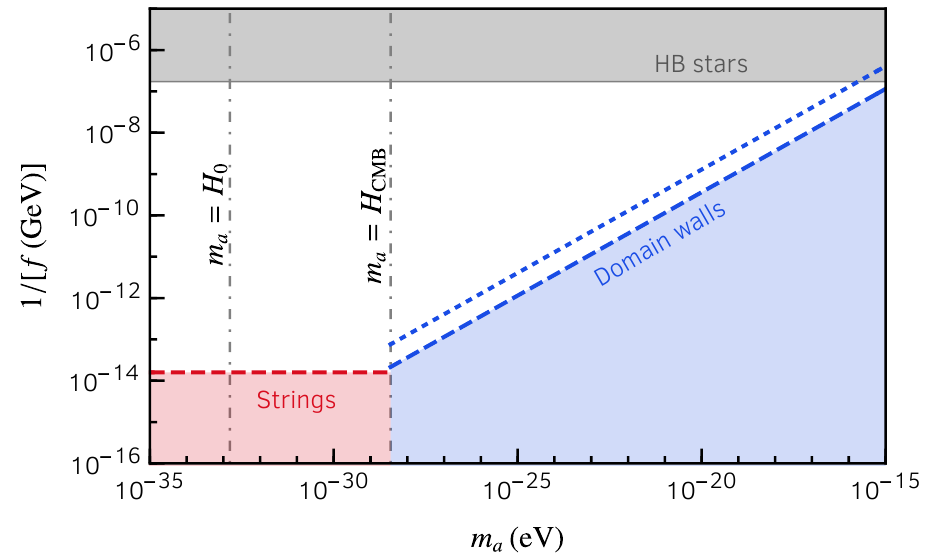
Figure 9 . Parameter space for polarization rotation and gravitational wave signatures. The gray shaded region is excluded by cooling bounds coming from Horizontal Branch stars [104] (assuming A = 1). The red shaded region is excluded by CMB measurements of strings coming from their gravitational e(cid:11)ects [105]. The blue region is excluded when N DW 6 = 1 due to the temperature (cid:13)uctuations induced by the gravitational potential of the domain wall [106]. Dashed and dotted lines correspond to (cid:24) = 10 and 100 respectively. The (cid:12)gure is cut o(cid:11) at large f , as for f & 10 16 GeV, the universe can not reheat to high enough temperature so that strings might not be